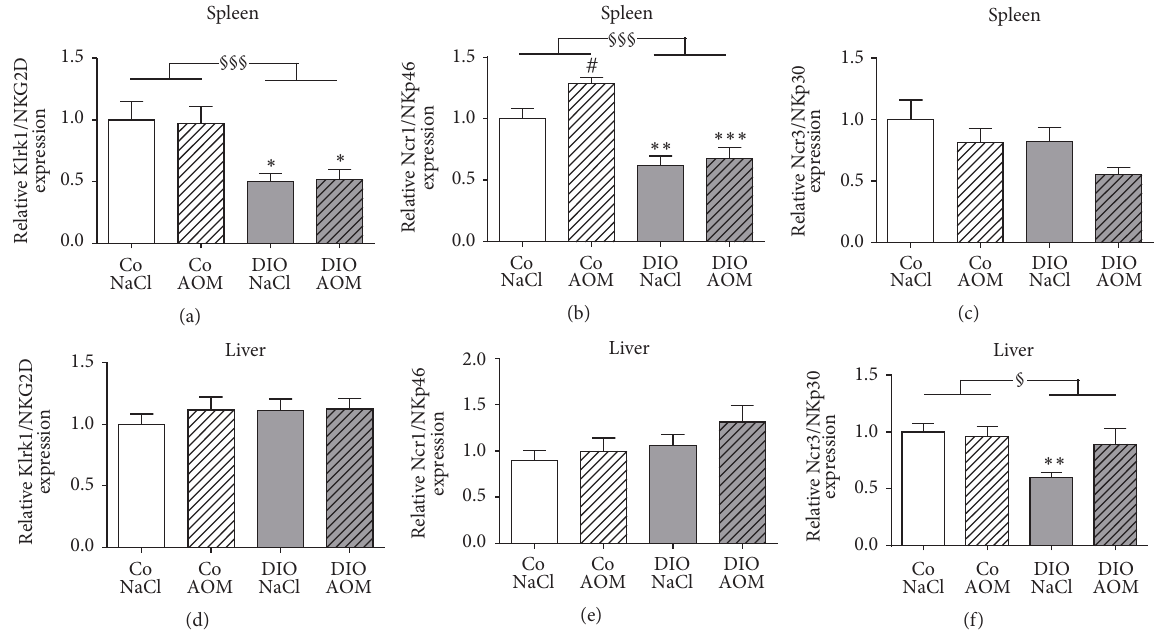
Figure 7: Splenic (a–c) and hepatic (d–f) mRNA expression of the NK cell activating receptors Klrk1/NKG2D (a, d), Ncr1/NKp46 (b, e), and Ncr3/NKp30 (c, f) in normal weight [Co] and obese [DIO] rats treated with NaCl or azoxymethane (AOM). Data are expressed as mean ± SEM of 𝑛 = 11 –14 animals per group. # 𝑃 < 0.05 compared to NaCl-treated control group; ∗ 𝑃 < 0.05 , ∗∗ 𝑃 < 0.01 , and ∗∗∗ 𝑃 < 0.001 , compared to appropriate control group. § 𝑃 < 0.05 , §§§ 𝑃 < 0.001 , and two-way-ANOVA, normal weight control groups compared to DIO